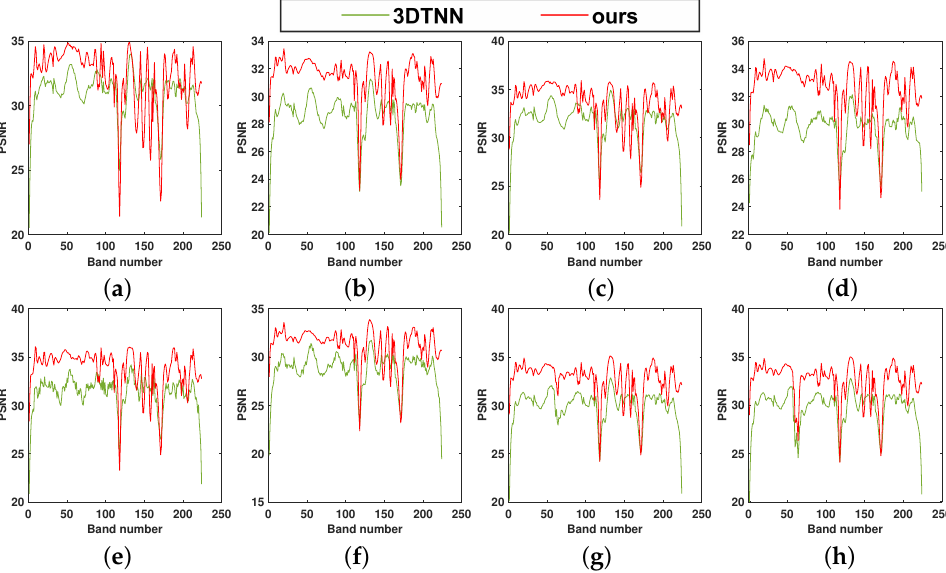
Figure 10. The PSNR values of each band in the dataset-2 after denoising by 3DTNN and our model under ( a ) case 1, ( b ) case 2, ( c ) case 3, ( d ) case 4, ( e ) case 5, ( f ) case 6, ( g ) case 7, ( h ) case